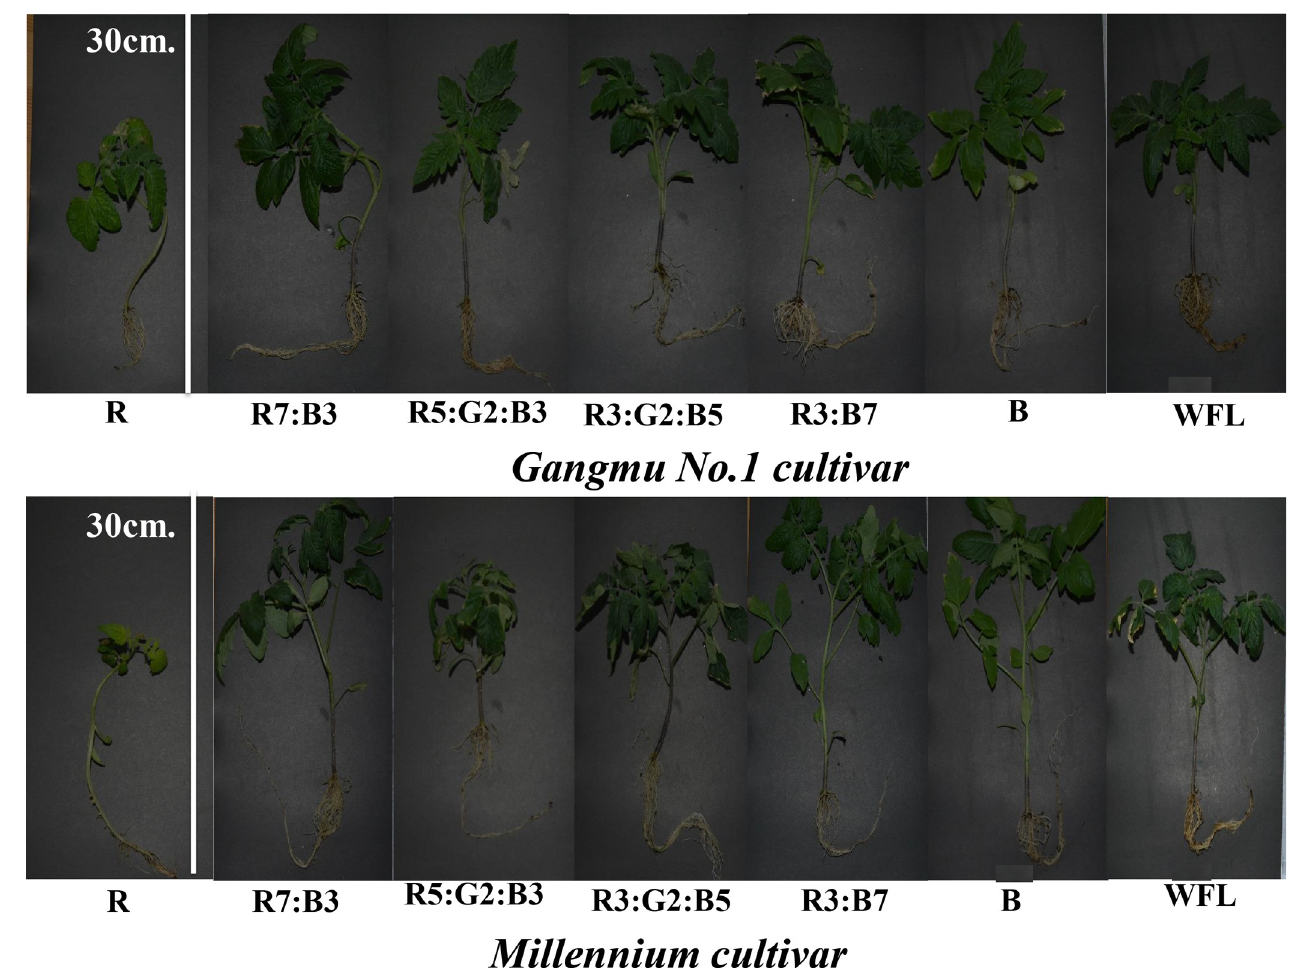
Fig 2. Tomato seedlings grown 40 days under different treatments of LED